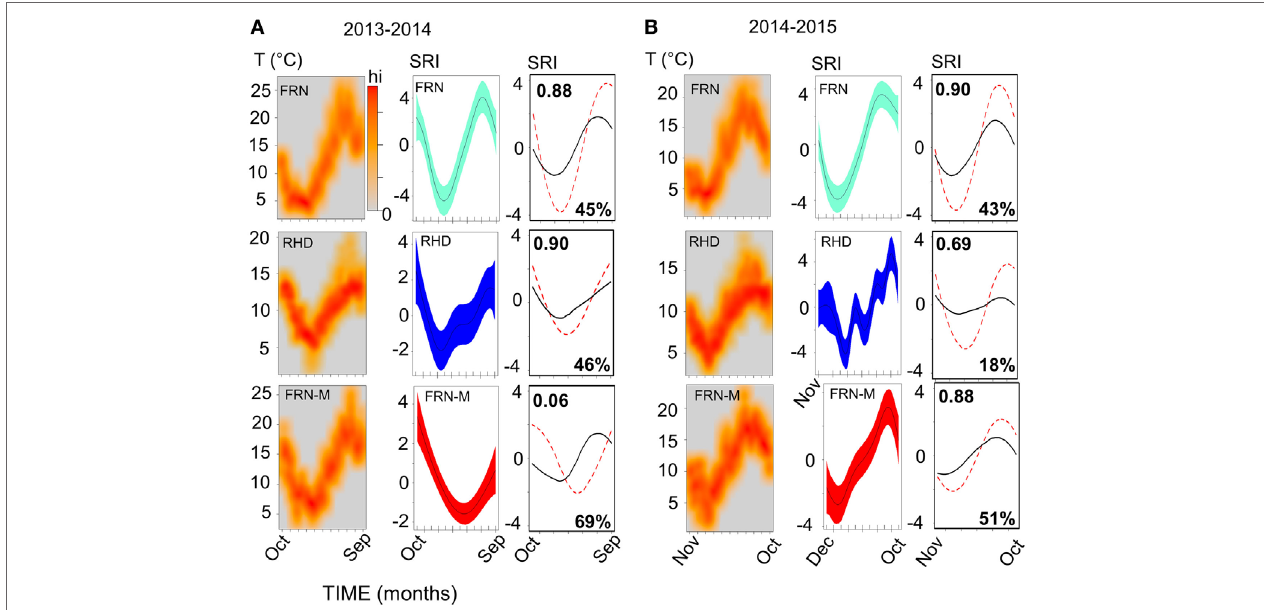
FigUre 4 | Sinusoid-like seasonal variation in the immune system of wild and mesocosm sticklebacks, as reflected by a seasonal reporter index (SRI) of expression in immune-associated genes, and its correspondence to variation in environmental temperature. Plots in (a) , for 2013–2014, and (B) , for 2014–2015, represent habitat-specific environmental temperature and SRI variation for an upland lake (FRN), a side-channel in the lowland section of a river (RHD) and semi-natural artificial mesocosm habitats stocked from FRN (FRN-M). Scatter of temperature (T) against time is plotted in the left-hand columns as a smoothed color density representation obtained through a (2D) kernel density estimate; based on recordings taken every 5 or 10 min. Middle columns show plots of SRI against time; the plotted (centered) line is a smoother from a confounder-adjusted generalized additive mixed model, on the scale of the model linear predictor, with 95% confidence interval shaded. The right-hand column shows plots of predicted SRI from a confounder-adjusted cosinor regression of SRI against time (red dotted line) and of predicted SRI from a corresponding model in which temporal sinusoid effects have been replaced by a thermal effect estimated from the experimental manipulation of temperature in the mesocosms (black line). The red dotted line thus represents observed seasonality, and the black line seasonality predicted from experimentally determined thermal effects. Correlation (Pearson, r ) between the observed and thermally predicted values is shown in the top left-hand corner of the plots; the amplitude of the thermally predicted variation, expressed as a percentage of the observed amplitude, is shown in the bottom right-hand corner (note that the observed and predicted variation may sometimes be considerably out-of-phase, as was the case for FRN-M in